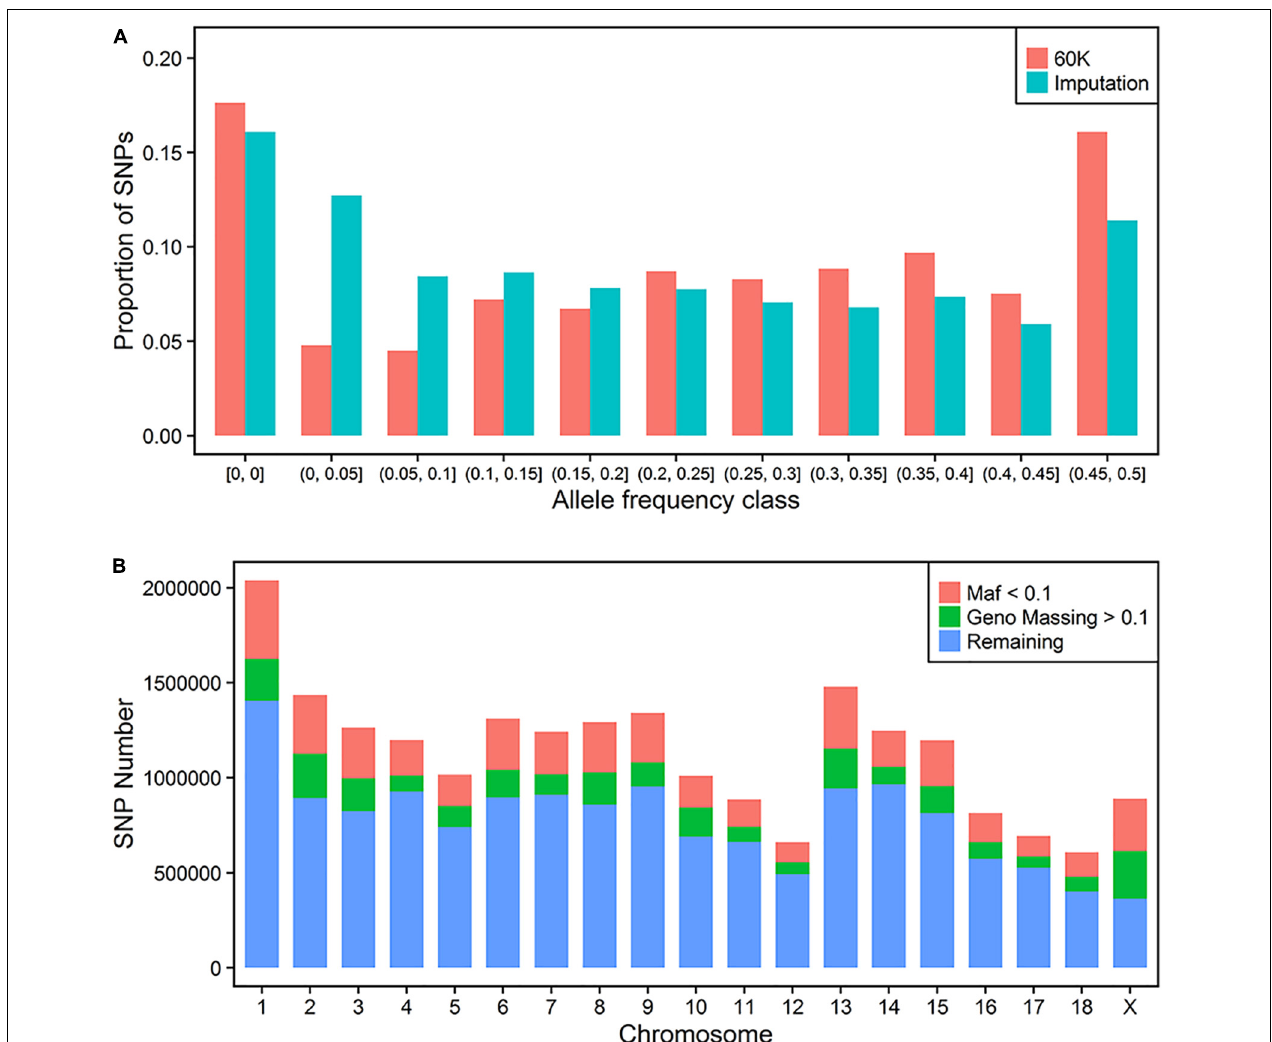
FIGURE 1 | Imputation of whole-genome sequence variants. Distribution of SNP frequencies of 60 K and imputed variants across MAF classes (A) . Quality control for imputed variants with MAF and genotype missing rate (B)